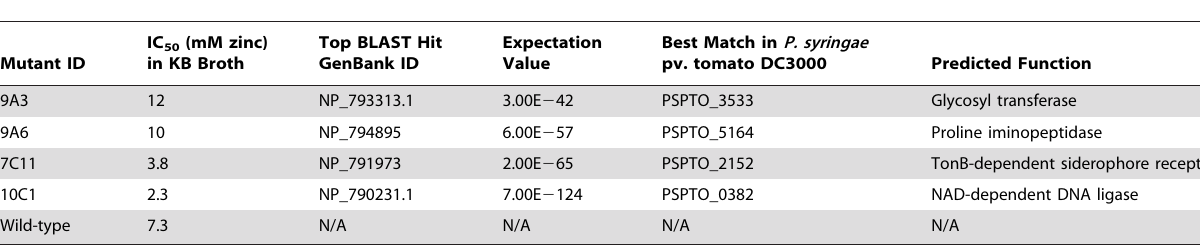
IC 50 (mM zinc) in KB